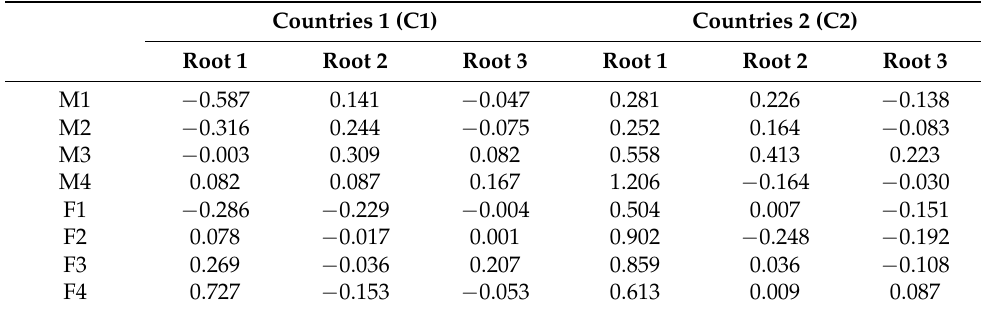
Table 3. Centroids distinguished according to country (C1 and C2), gender (M, F), and age (1— emerging adults 18–25 years, 2—young adults 26–39 years, 3—middle-aged adults 40–59 years